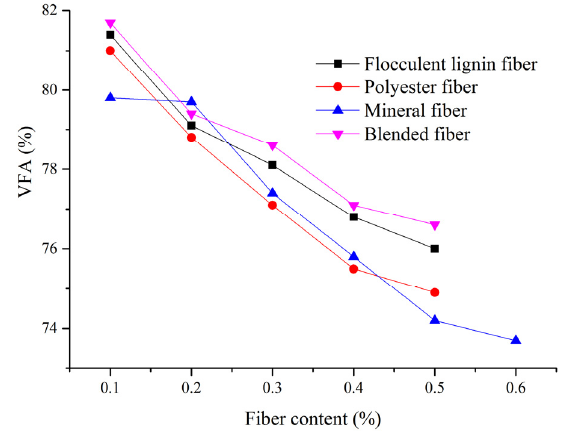
Figure 4. VFA of SMA specimens with four different fiber types.